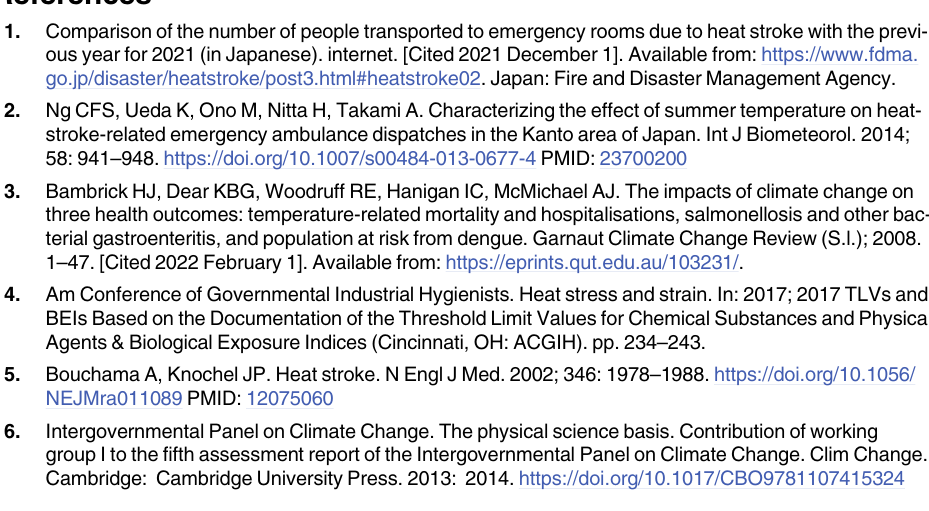
S1 Fig. Actual measured and estimated core body temperatures per individual. Dotted lines show actual measured values, while solid lines show estimated values. S2 Fig. Bland-Altman plot for each participant. Solid line and dashed line are indicated bias and ± 1.96SD,